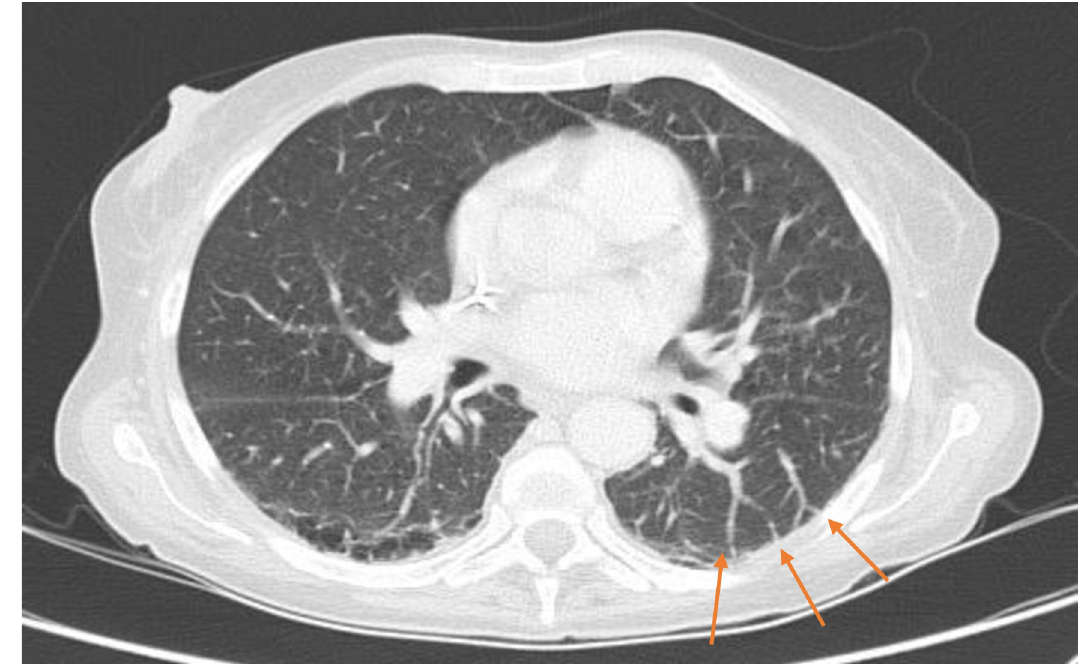
Fig 1. Type 1 pulmonary vascular abnormality. Type 1 pulmonary vascular abnormality was defined as the presence of dilated peripheral arteries that do not taper normally and that touch the pleural surface in the lower lobes